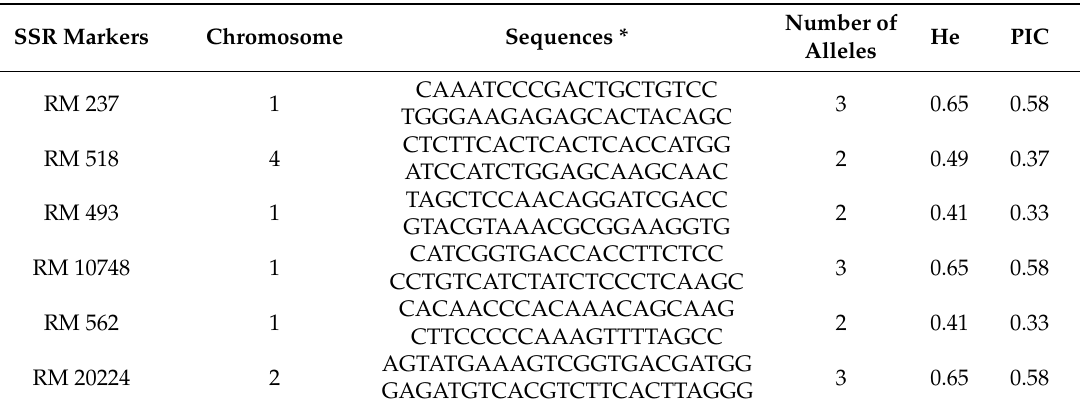
Table 7. Polymorphic markers information.